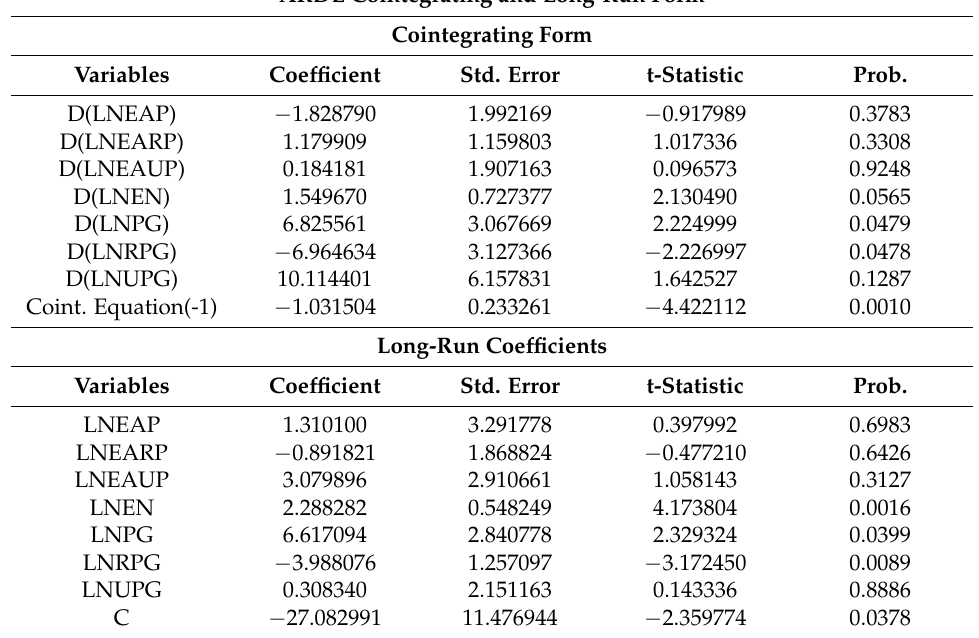
Table 5. Long-Run